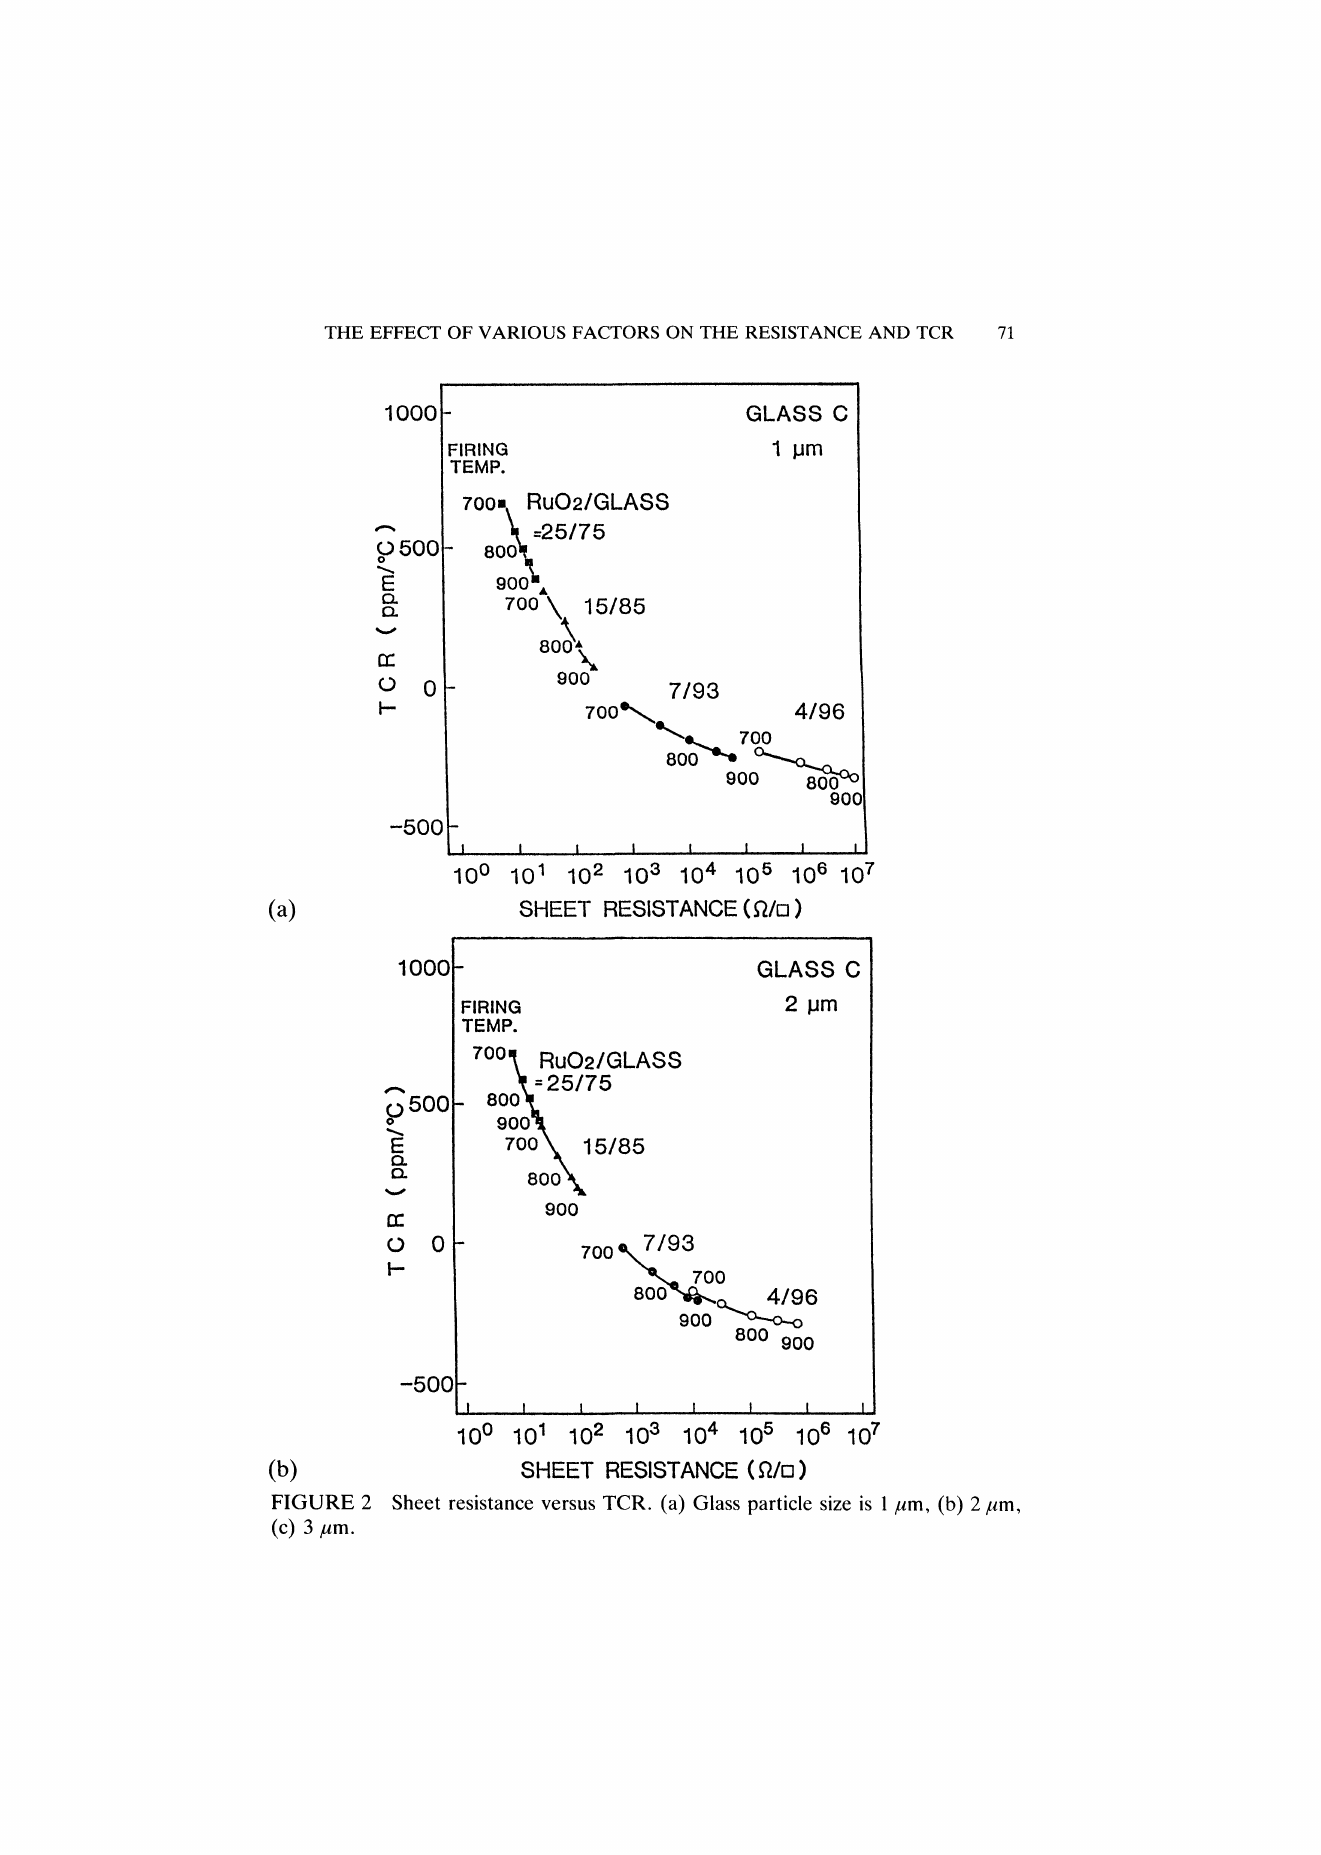
FIGURE 2 Sheet resistance versus TCR. (a) Glass particle size is #m, (b) 2 (c) 3